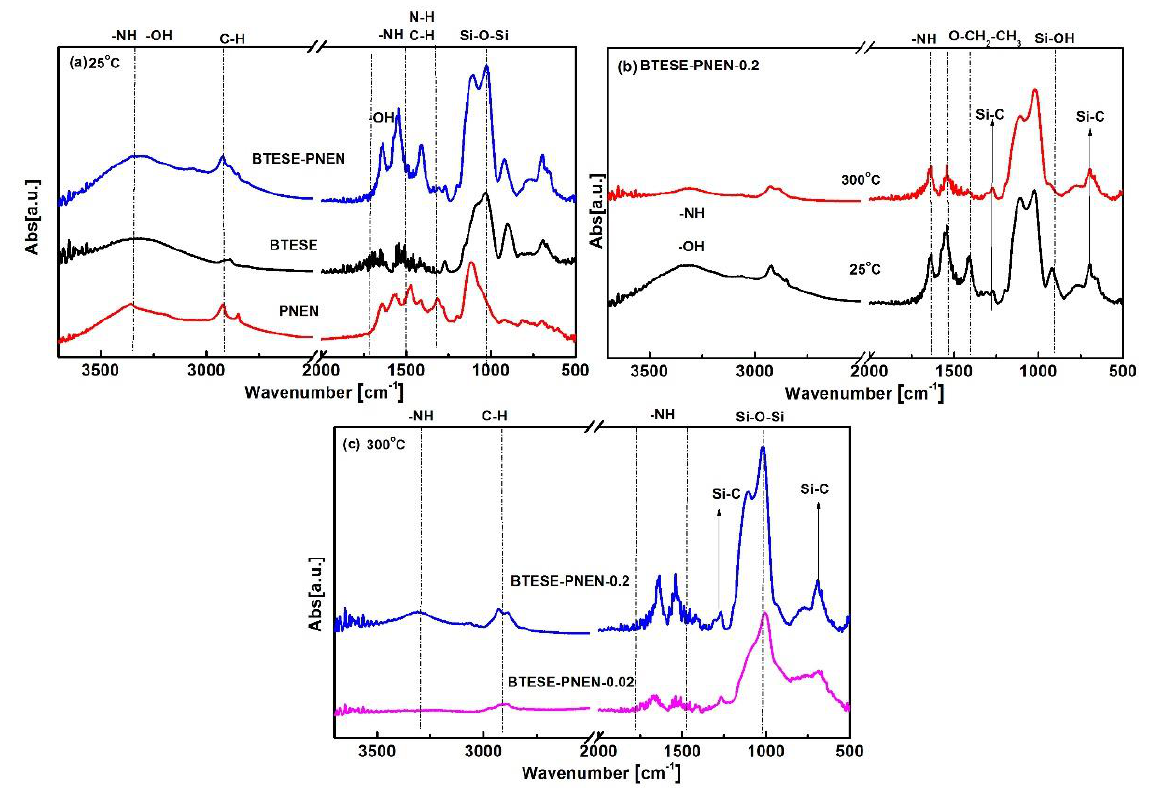
Figure 4. FT-IR spectra of ( a ) BTESE, PNEN and composite BTESE-PNEN (0.2) films calcination at 25 °C and ( b ) BTESE- PNEN-0.2 film calcination at 25 and 300 °C; ( c ) molar ratio of PNEN to BTESE at 0.2 and 0.02 formed films calcination at 300 °C in N 2 atmosphere.